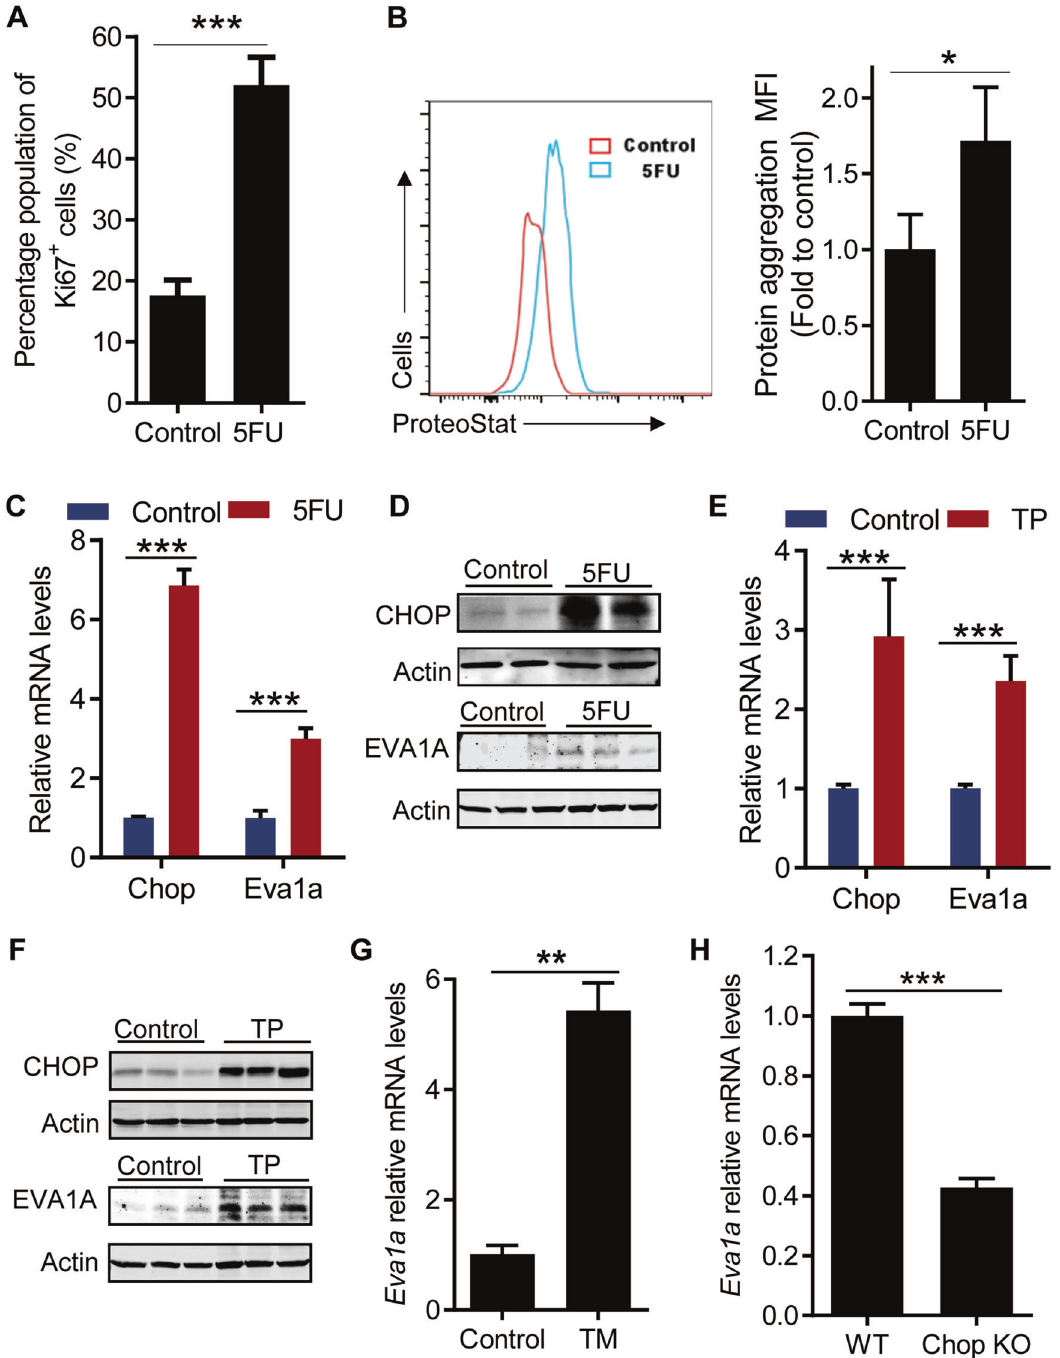
Fig. 2 ER stress promotes EVA1A expression during hematopoietic regeneration. A – D WT mice were treated with a single dose of 5FU (150 mg/kg) and sacri fi ced at day 8 posttreatment. A The results present the percentage of Ki67-positive cells in SLAM-HSCs (Lin − Sca1 + cKit + CD48 − CD150 + ) after 5FU treatment ( n = 4). B Representative FACS histogram (left) and quanti fi cation (right) of the level of protein aggregation in SLAM-HSCs after 5FU treatment ( n = 4). C Relative mRNA levels of CHOP and EVA1A in LSK (Lin − cKit + Sca1 + ) cells from WT mice after 5FU treatment ( n = 9). D Western blot analysis of CHOP and EVA1A protein levels in Lin − (Lineage − ) cells from WT mice after 5FU treatment. E Relative mRNA levels of CHOP and EVA1A in LSK cells from lethally irradiated mice after transplanted (TP) with 2 × 10 6 BM cells 14 days. ( n = 9) F Western blot analysis of CHOP and EVA1A protein levels in Lin − cells from mice as in ( E ). G Relative mRNA level of EVA1A in LSK cells from WT mice treated with 0.5 mg/kg Tunicamycin for 1 Week ( n = 3). H The relative mRNA level of EVA1A in LSK cells from WT and Chop KO mice ( n = 3). Data are presented as mean ± SD, (* p < 0.05, ** p < 0.01, and *** p < 0.001).